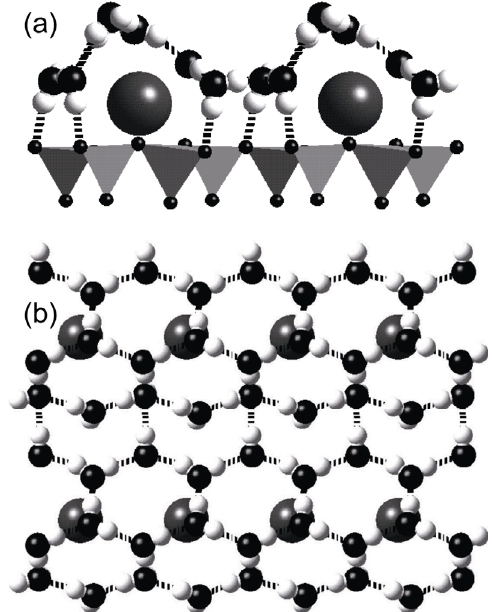
Fig. 2 (a) Side view and (b) top view of 2D ice structure of adsorbed water on mica surface. H-bond network consists of distorted hexagons. Reproduced with permission from Ref. [54], © American Physical Society 1997.